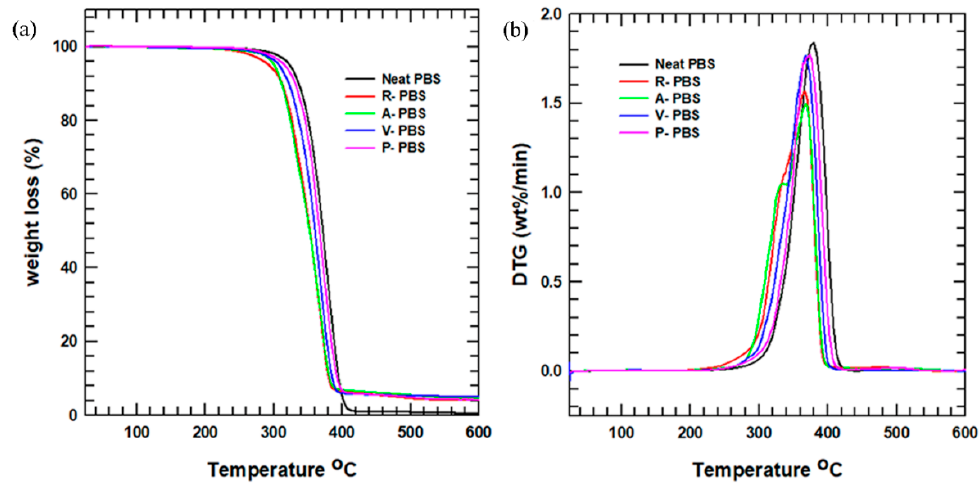
Figure 6. ( a ) TGA curve of the neat PBS and its composites; ( b ) Derivative thermogram curves of TGA. Likewise, the temperature at which the maximum degradation occurred is shown in Figure 6b, representing the derivative of the TGA curve as a function of temperature. This figure